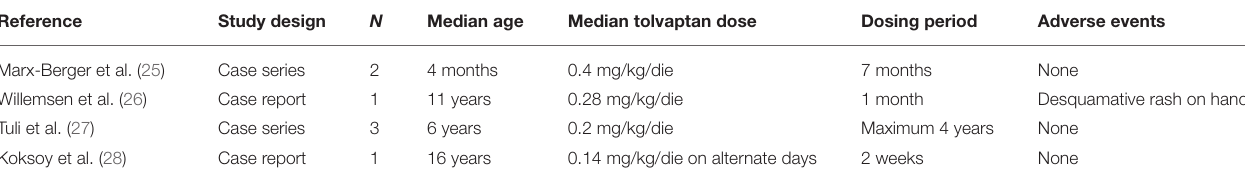
TABLE 2B | Characteristics of the 7 children with SIADH treated with tolvaptan described in the